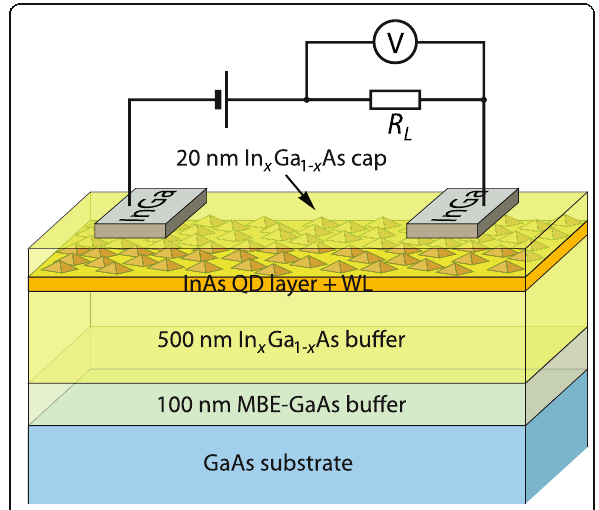
Fig. 1 Color online. Scheme of the metamorphic InAs/In x Ga 1 − x As QD structures and their connection for the photoelectric